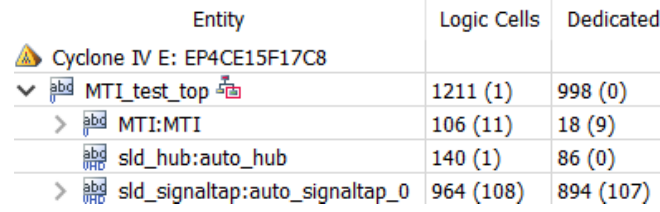
Figure 17. Moving target detection resource occupancy.